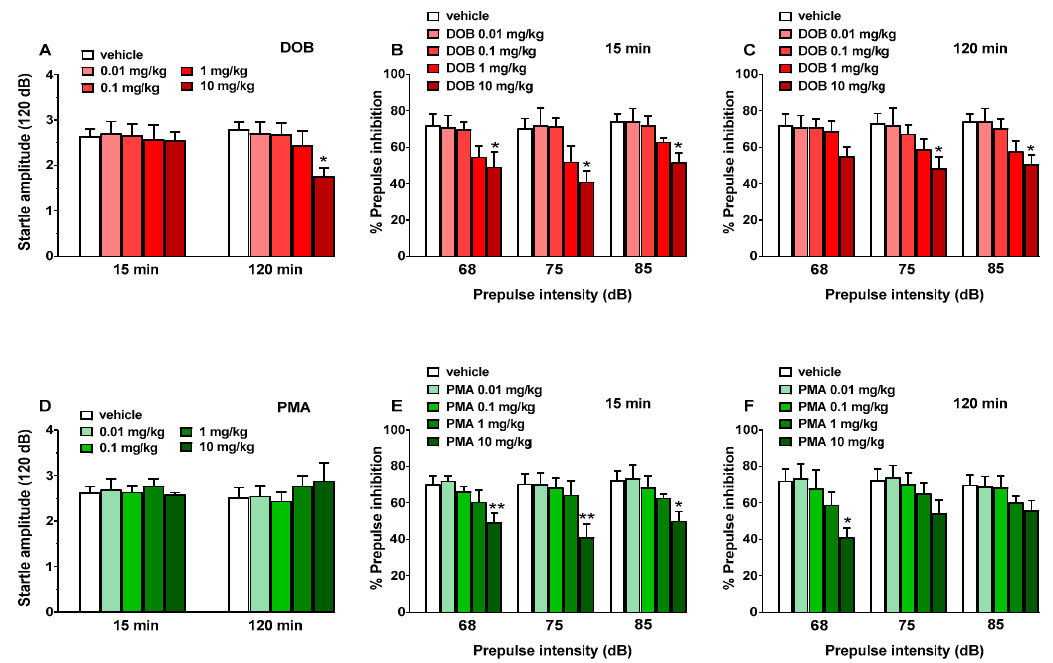
Figure 4. Effect of DOB (0.01–10 mg/kg i.p.; panel A – C ) and PMA (0.01–10 mg/kg i.p.; panel D – F ) on startle amplitude (panels A and D ) and prepulse inhibition (PPI) in mice (panels A , B , E , and F ). Effects on PPI are shown for the three prepulse intensities (68, 75, and 85 dB), 15 min (panels B and E ), and 120 min (panels C and F ) after treatment. Startle amplitude was expressed in absolute values (in dB) and prepulse inhibition (PPI) was expressed as the percentage decrease in the amplitude of the startle reactivity caused by presentation of the prepulse (% PPI; see Material and Methods) and values represent mean ± SEM of 10 animals for each treatment. The statistical analysis was performed with a one-way ANOVA followed by Bonferroni’s test for multiple comparisons. * p < 0.05 and ** p < 0.01 versus vehicle.